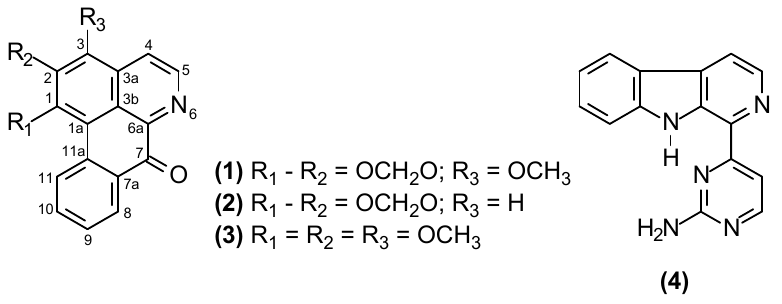
Figure 1. Alkaloids isolated from the branches of A. foetida